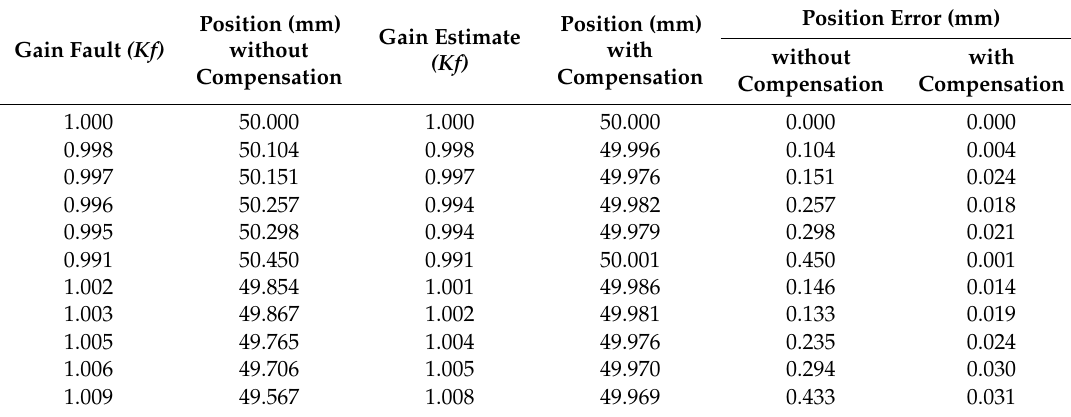
Figure 23. Gain compensation by continuous gain scheduling. Table 5. Gain compensation result for continuous gain scheduling.